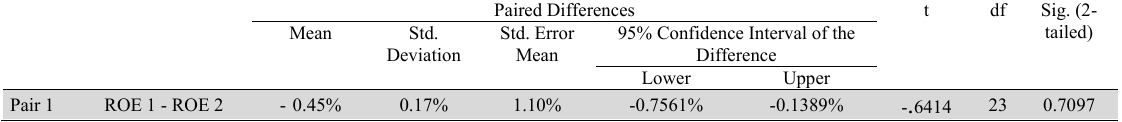
Paired sample T-test SMEs ROE